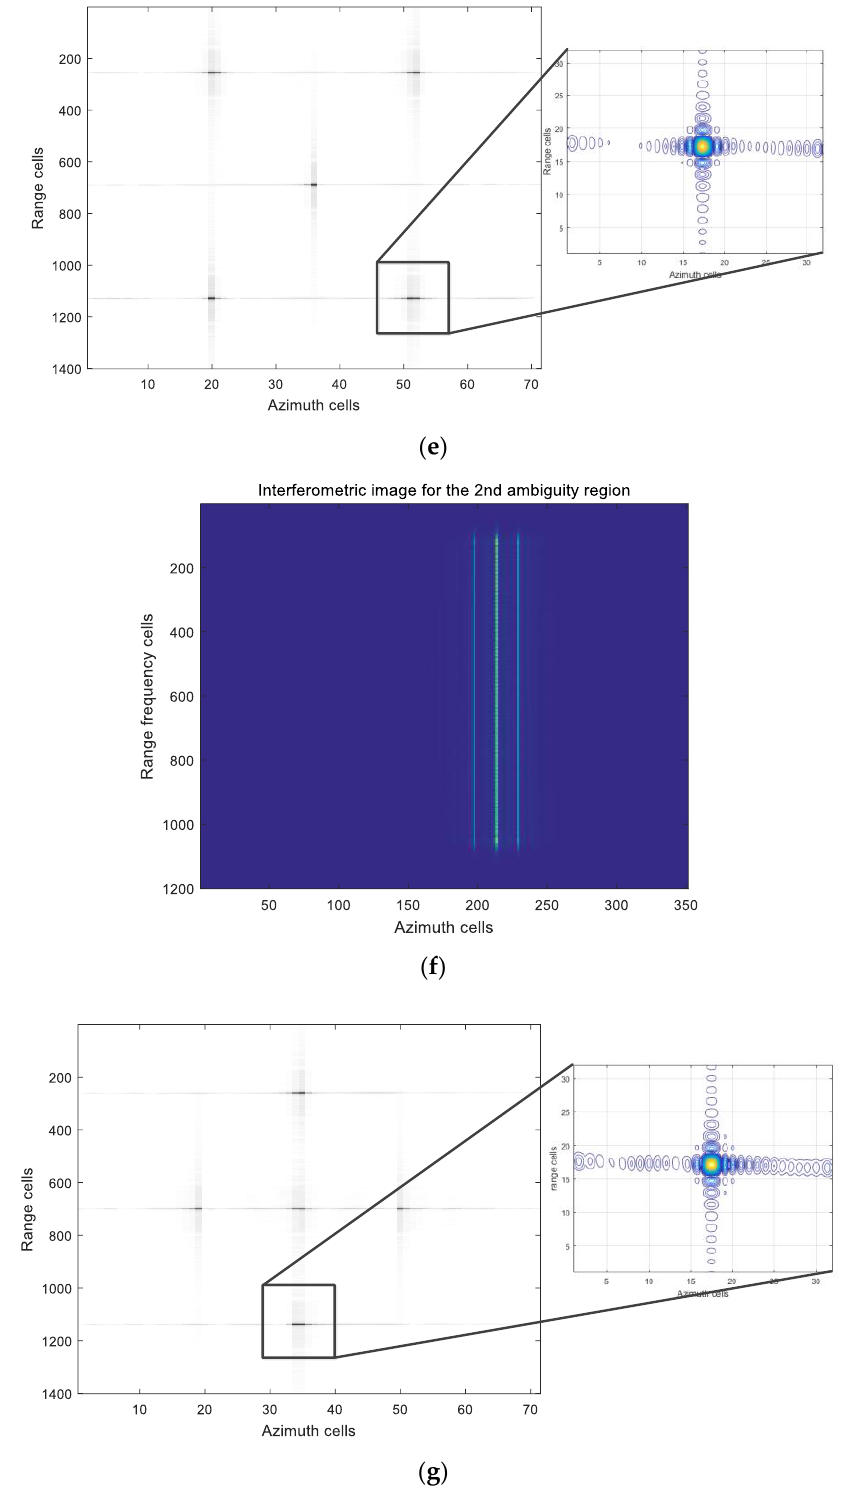
Figure 12. Results using the proposed method: ( a ) interferometric image using the proposed method; ( b ) interferometric image of the unambiguous region after passband time filter; ( c ) focused result of the unambiguous region; ( d ) interferometric image of the 1st ambiguous region after passband time filter; ( e ) focused result of the 1st ambiguous region; ( f ) interferometric image of the 2nd ambiguous region after passband time filter; ( g ) focused result of the 2nd ambiguous region.